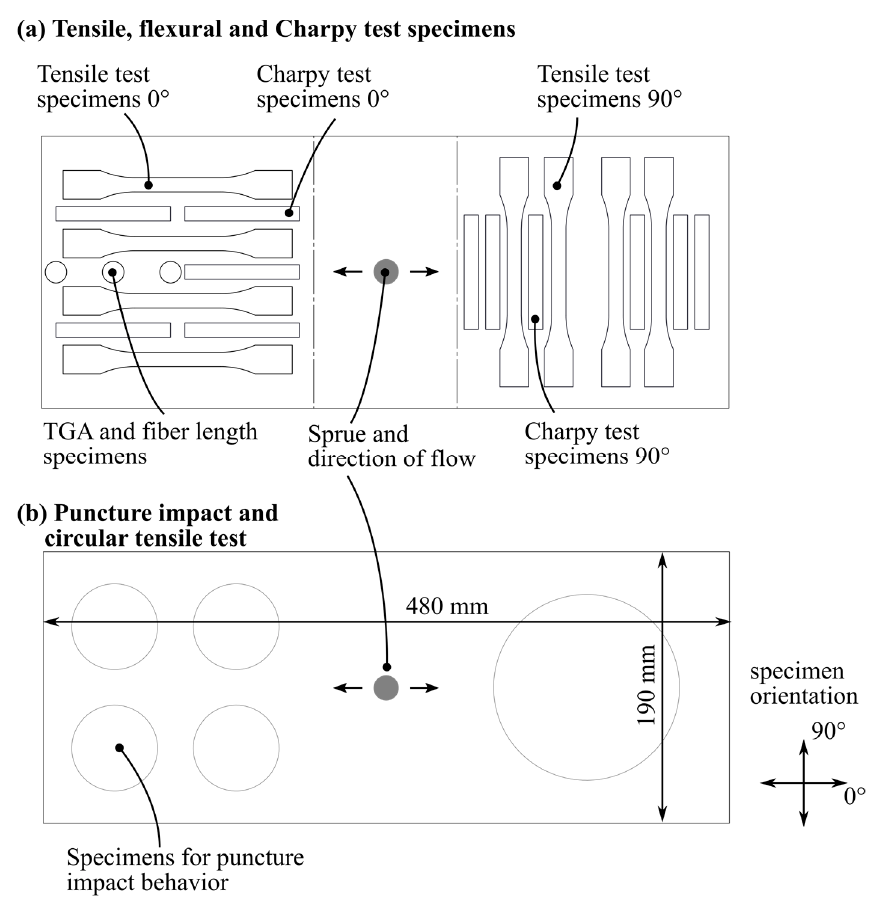
Figure 5. Cutting pattern for waterjet cutting of test specimens.